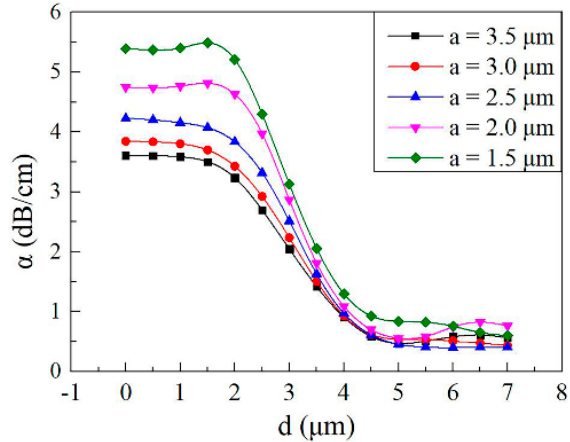
Figure 6. Calculated mode losses induced by graphene film and electrode with different horizontal distances between the center of the core layer and the electrode ( a 1 = 3.5 µ m, h 1 = 1.24 µ m; a 2 = 3 µ m, h 2 = 1.22 µ m; a 3 = 2.5 µ m, h 3 = 1.20 µ m; a 4 = 2 µ m, h 4 = 1.18 µ m; a 5 = 1.5 µ m, h 5 = 1.14 µ m; m = 6 µ m, L = 1 cm, n c 1 = 1.48, n c 2 = 1.478 and n 1 = 1.444).